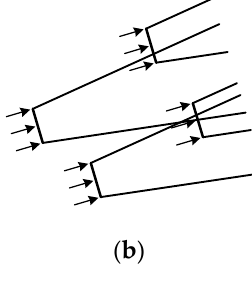
Figure 3. ( a ) Wind direction is 0°. ( b ) Wind direction is